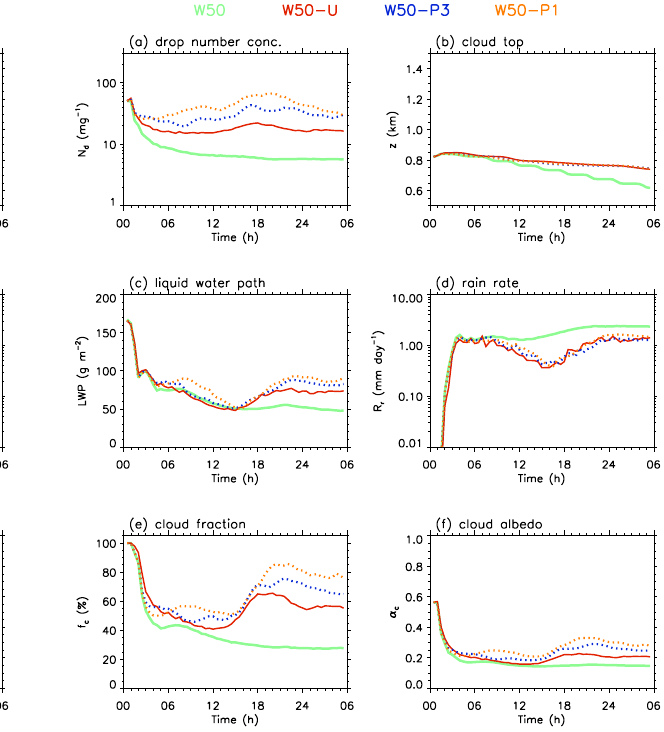
Fig. 6. Same as Fig. 5 but for the W50